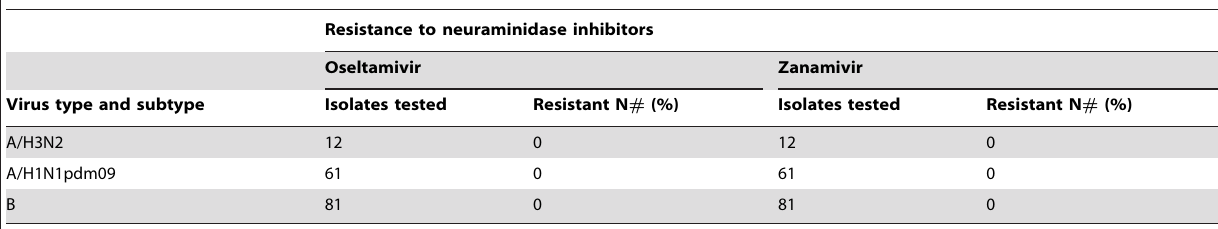
Table 3. Neuraminidase inhibitors resistance in influenza viruses,